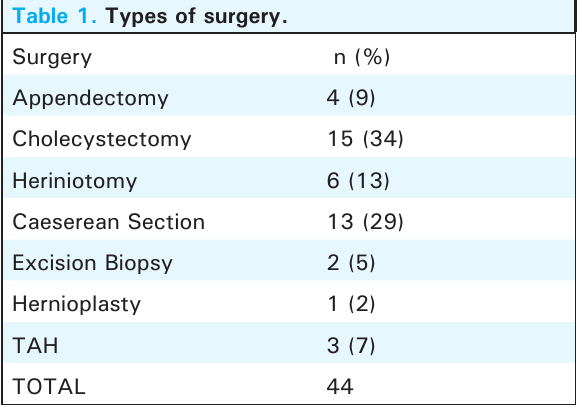
Table 1. Types of